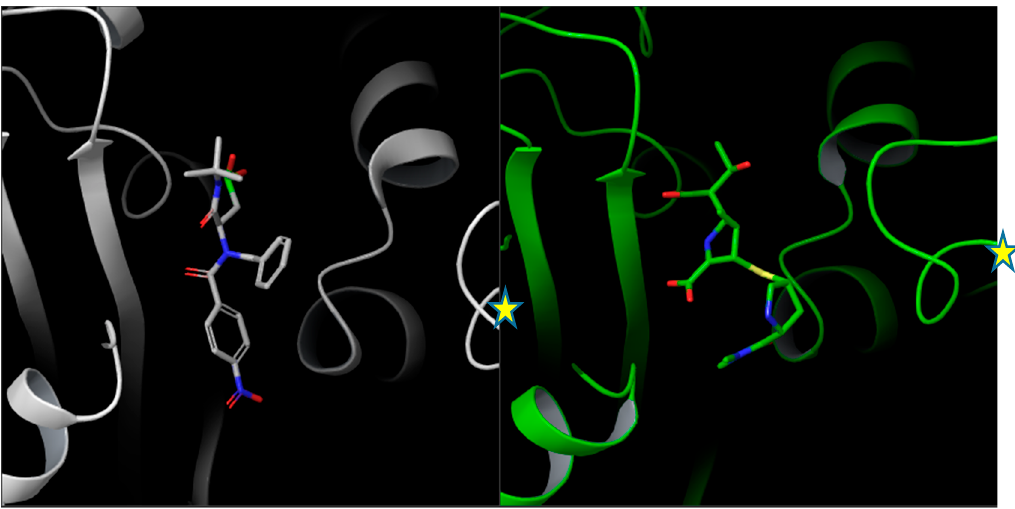
Figure 4. 3D comparison between the predicted binding mode of compound 6e (on the left) and the X-ray structure of the OXA-23/meropenem complex (on the right panel). The secondary structure of the enzyme is shown as a cartoon. The yellow stars highlight the position of Phe110. The 3D structures of the complexes were previously structurally aligned and superimposed; here they are displayed in two panels for clarity. The last frame of MD simulations of the 6e /OXA-23 complex is represented on the left.